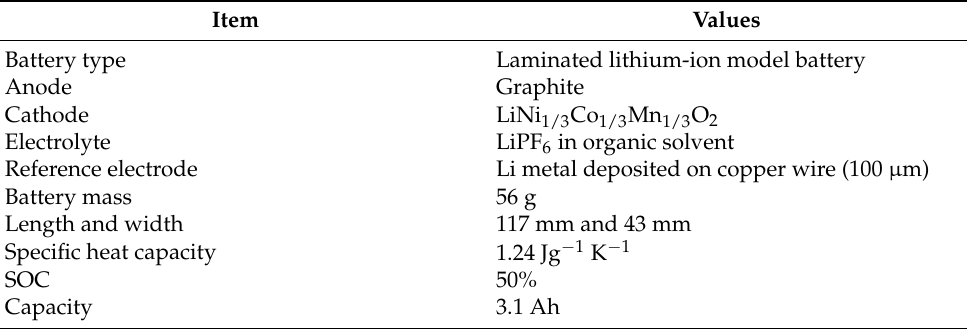
Table 1. Specifications of the test batteries.